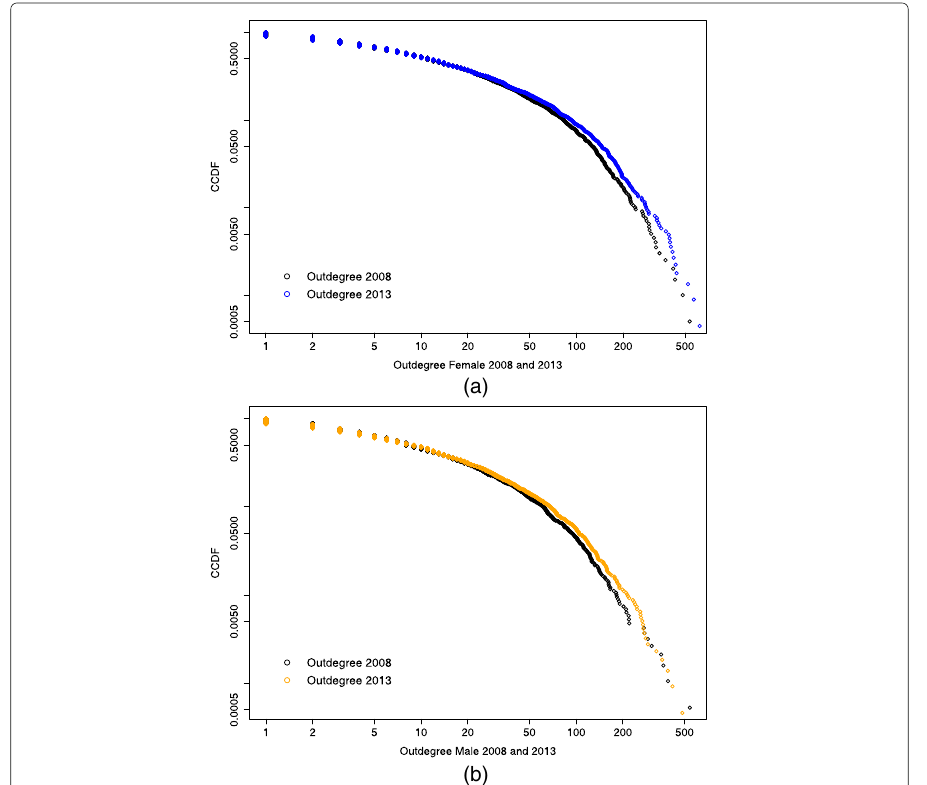
Fig. 8 Female and male outdegree distribution compared by year. Complementary cumulative distribution function (CCDF) on log-log scale of the female (a) and male (b) outdegree distribution for the years 2008 and